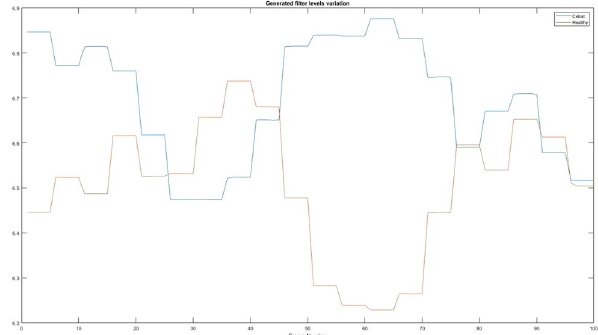
Figure 19. The value of entropy. Red = Healthy and Blue = Celiac.